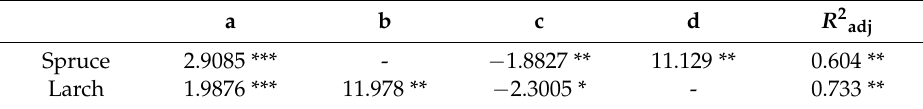
Table 7. Estimates for the coefficients and statistics of Equation (7).